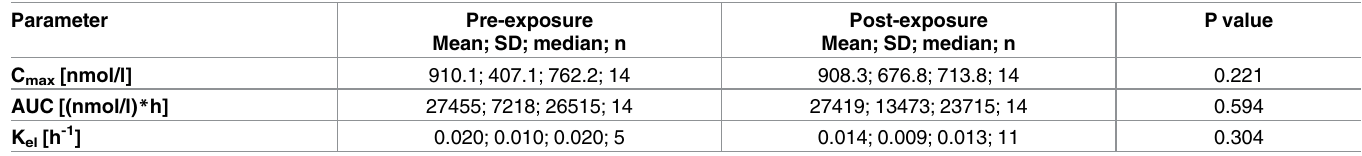
Table 2. Pharmacokinetic